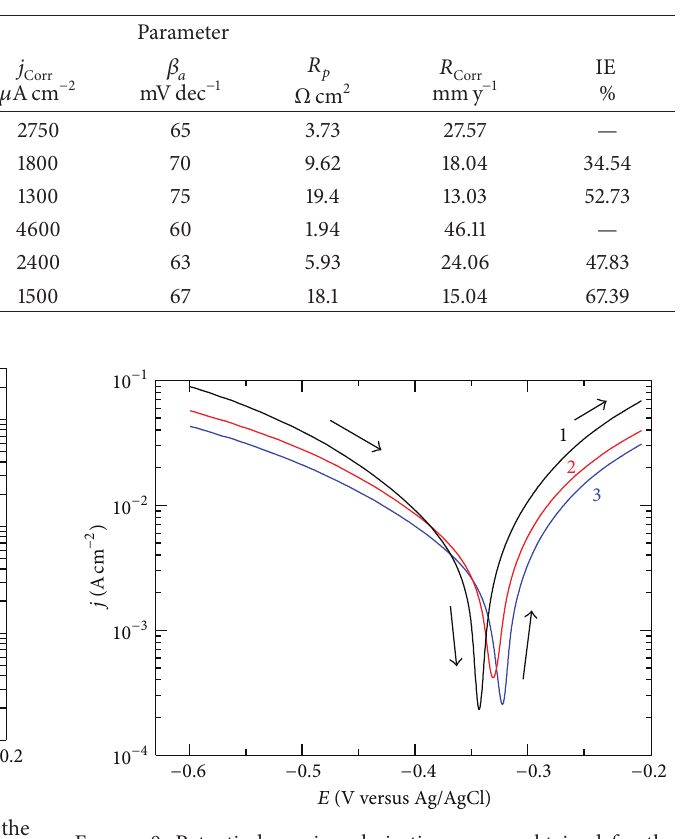
Figure 8: Potentiodynamic polarization curves obtained for the HSLA steel after its immersion for 10min in 2.0M H 2 SO 4 in the absence(1)andthepresenceof(2)1.0 mMATAand(3)5.0 mMATA, respectively.